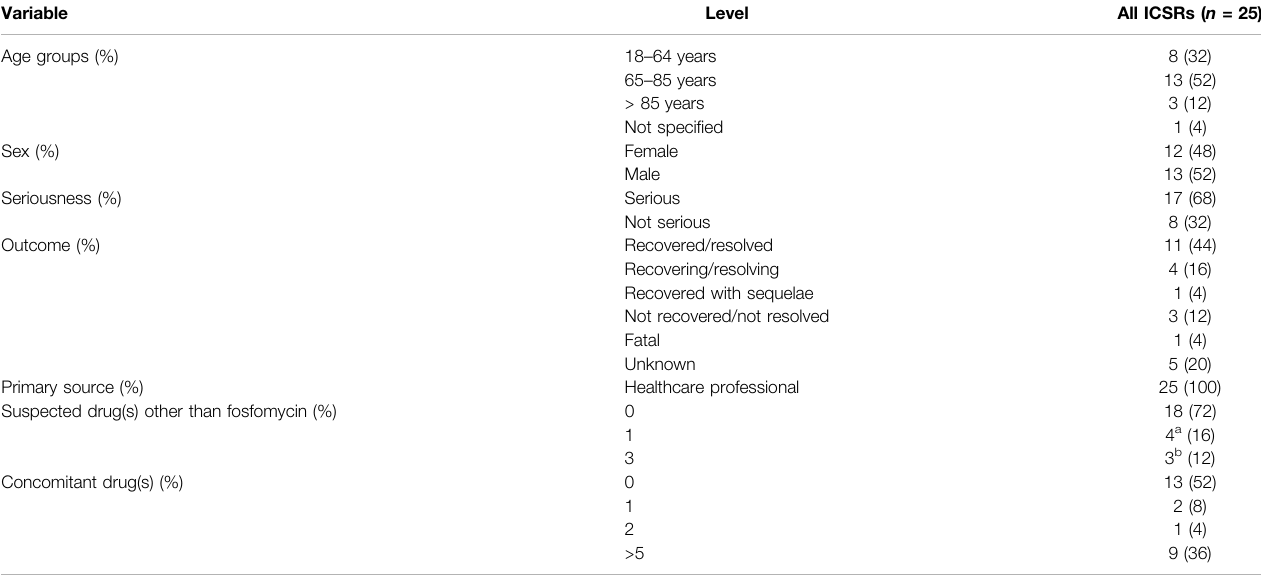
TABLE 1 | Demographic characteristics and distribution for seriousness, outcomes, primary source, number of suspected drugs other than fosfomycin, and number of concomitant drugs of ICSR related to hypernatremia associated with fosfomycin among those reported in the EudraVigilance database from the date of